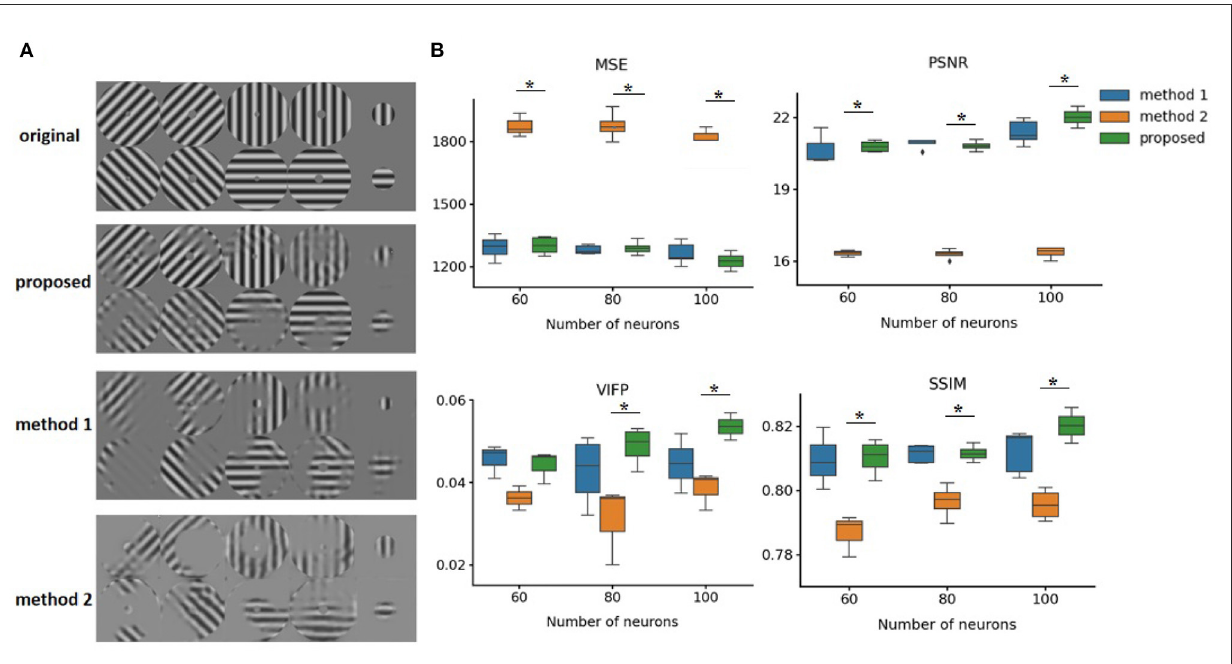
FIGURE6 Comparing performance of different reconstruction methods. (A) Original neutral images and reconstructed images. Method 1 and Method 2 are both based on autoencoder structures, but use MSE and SSIM loss functions, respectively. (B) Reconstruction loss for original images using different methods. * p < 0.05 compared proposed method and method 2 in all four indicators when using 100 neurons. MSE, Mean-Squared Loss; SSIM, Structure Similarity Index Measure; PSNR, Peak signal-to-noise ratio; VIFP, visual information fidelity and pixel domain. Error bars represent 95% confidence